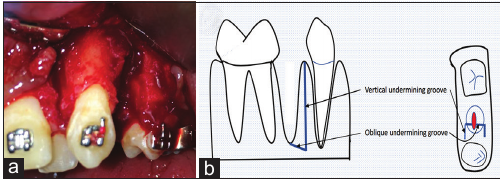
FIGURE 2. (a) Surgical osteotomy in the upper jaw; (b) osteotomy cut drawing shows the vertical and oblique undermining groove in the lower jaw distal to lower right first